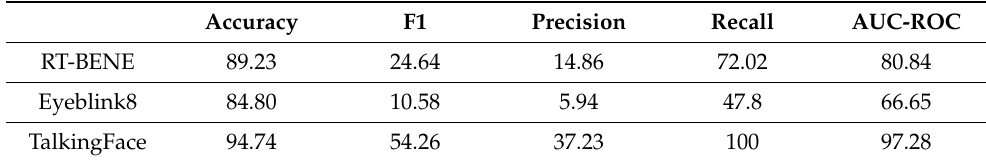
Table 2. Results for EAR with constant threshold.